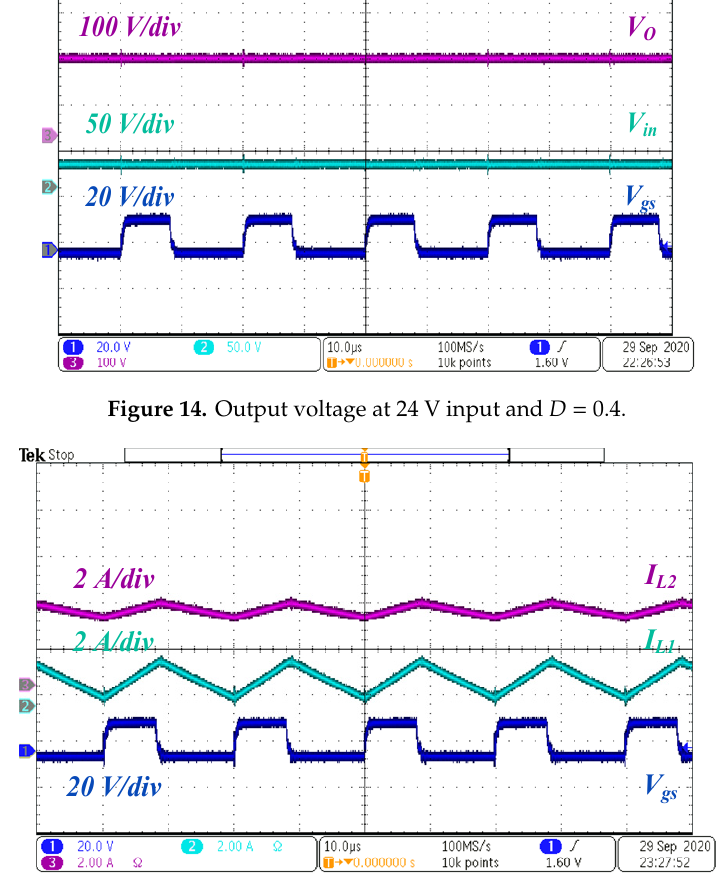
Figure 15. Inductor currents of L 1 and L 2 at D = 0.4.